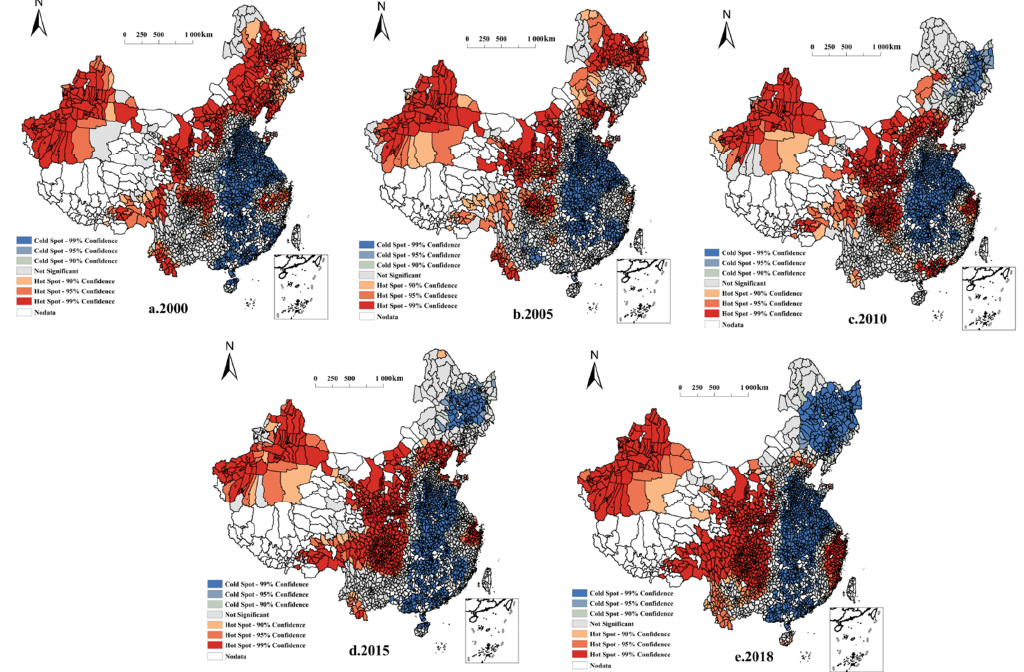
Figure 5. Hot spot analysis of the non-grain production rate.